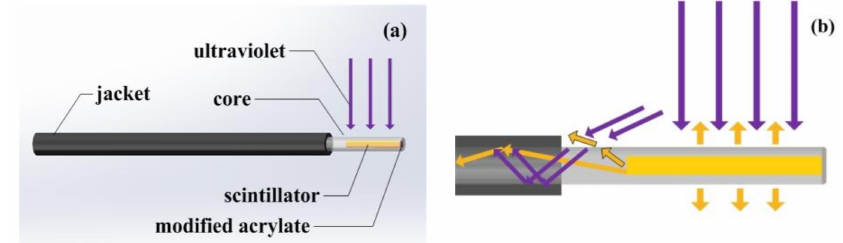
Figure 2. The structure of the UVOFS. ( a ) the geometry of the UVOFS, ( b ) the schematic of the optical signal transmission in the sensor’s probe.